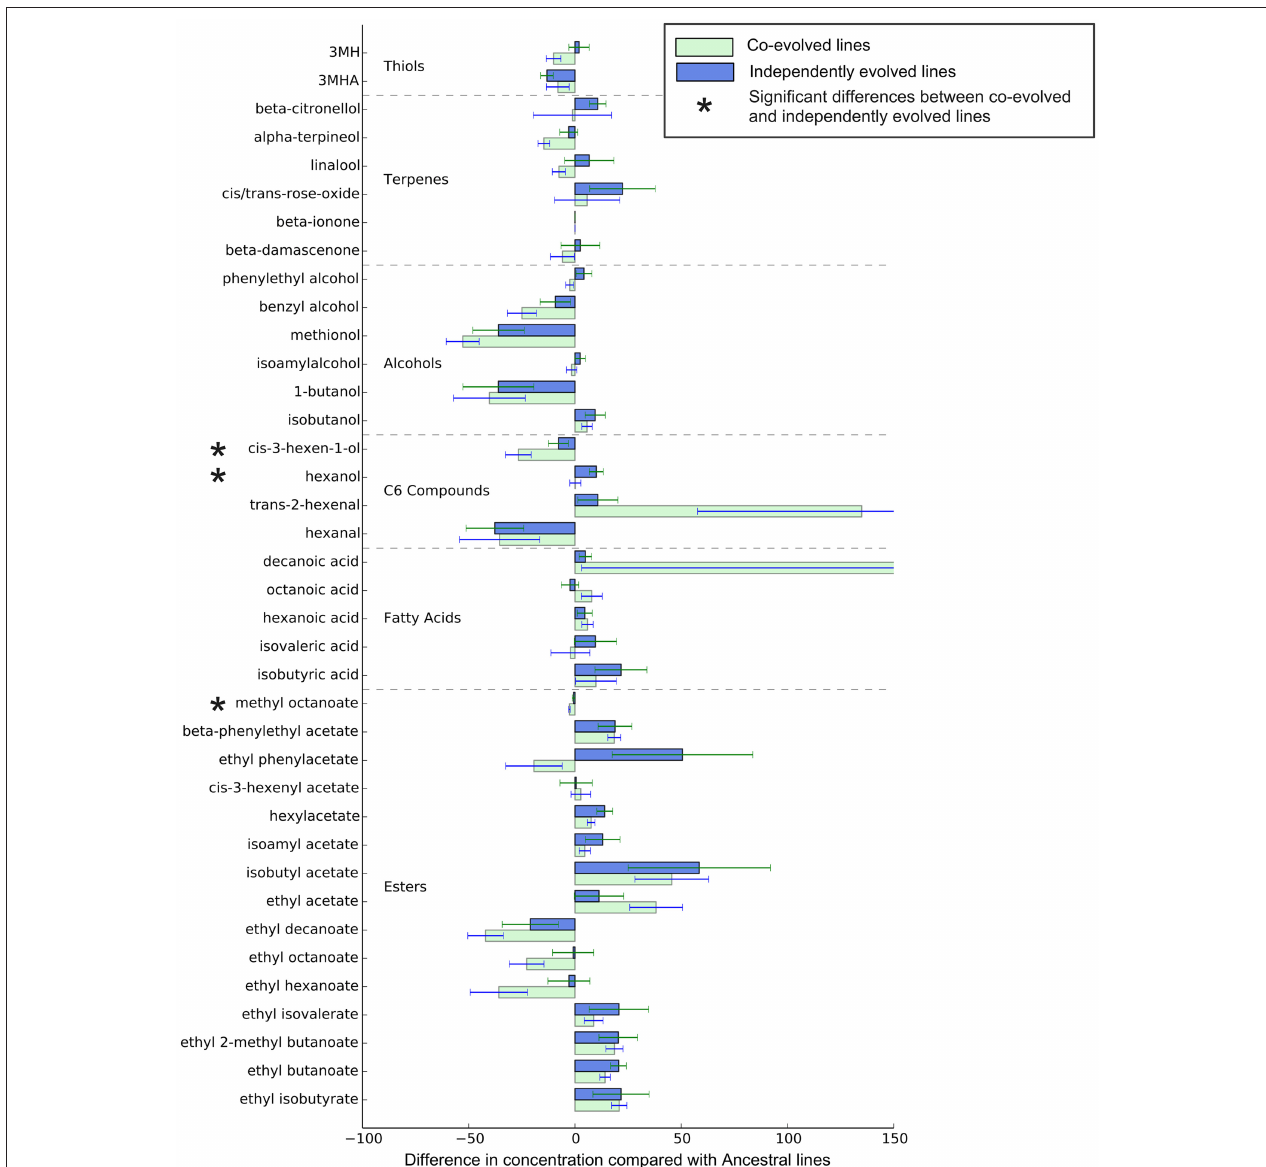
FIGURE 5 | Relative metabolite concentrations of co-evolved and independently evolved lines in Juice A—the juice they were evolved in. The concentrations of metabolites are the proportional difference in concentration compared to the ancestral line.